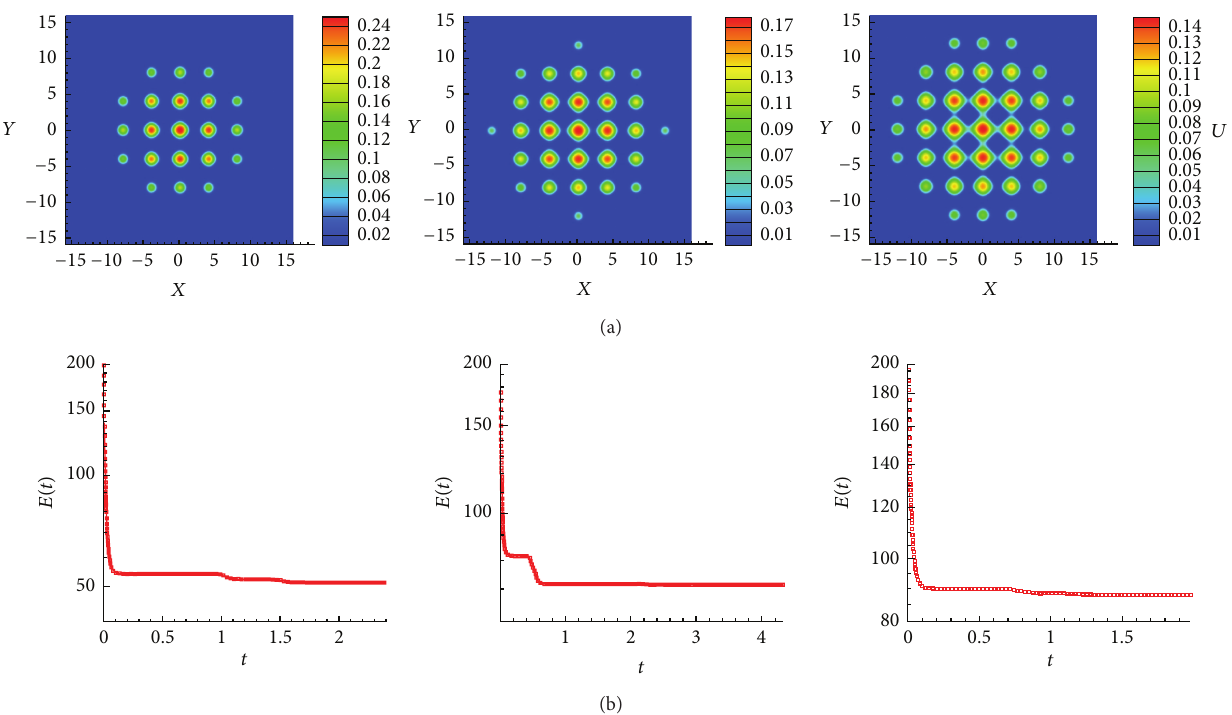
Figure 1: The ground state (top row) and time evolution of energy (bottom row) with fixed 𝑑 = 4 and 𝛽 = 1000 , 3000 , 6000 from left to right in Example